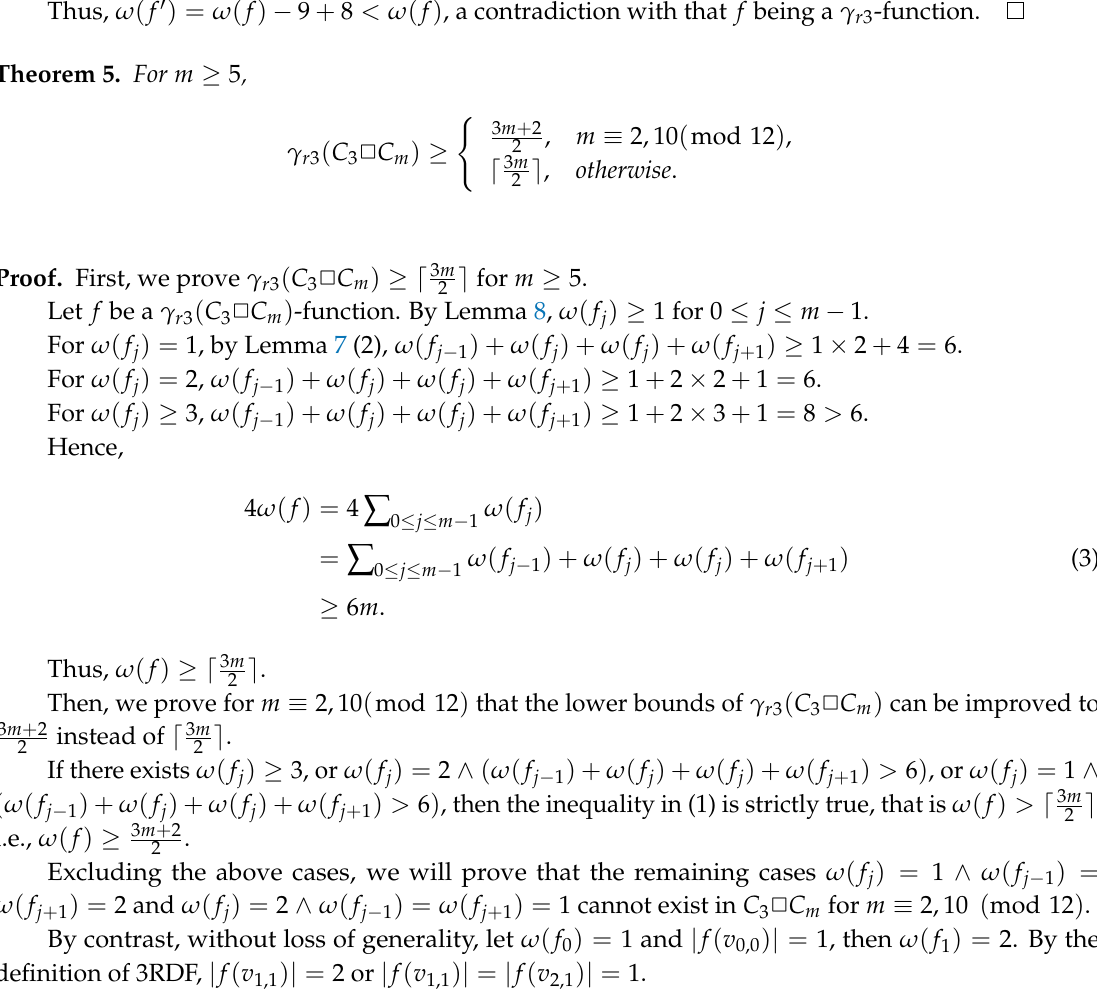
Figure 11. Sketch of f ′ Figure 11. The sketch of f (cid:48) in Lemma